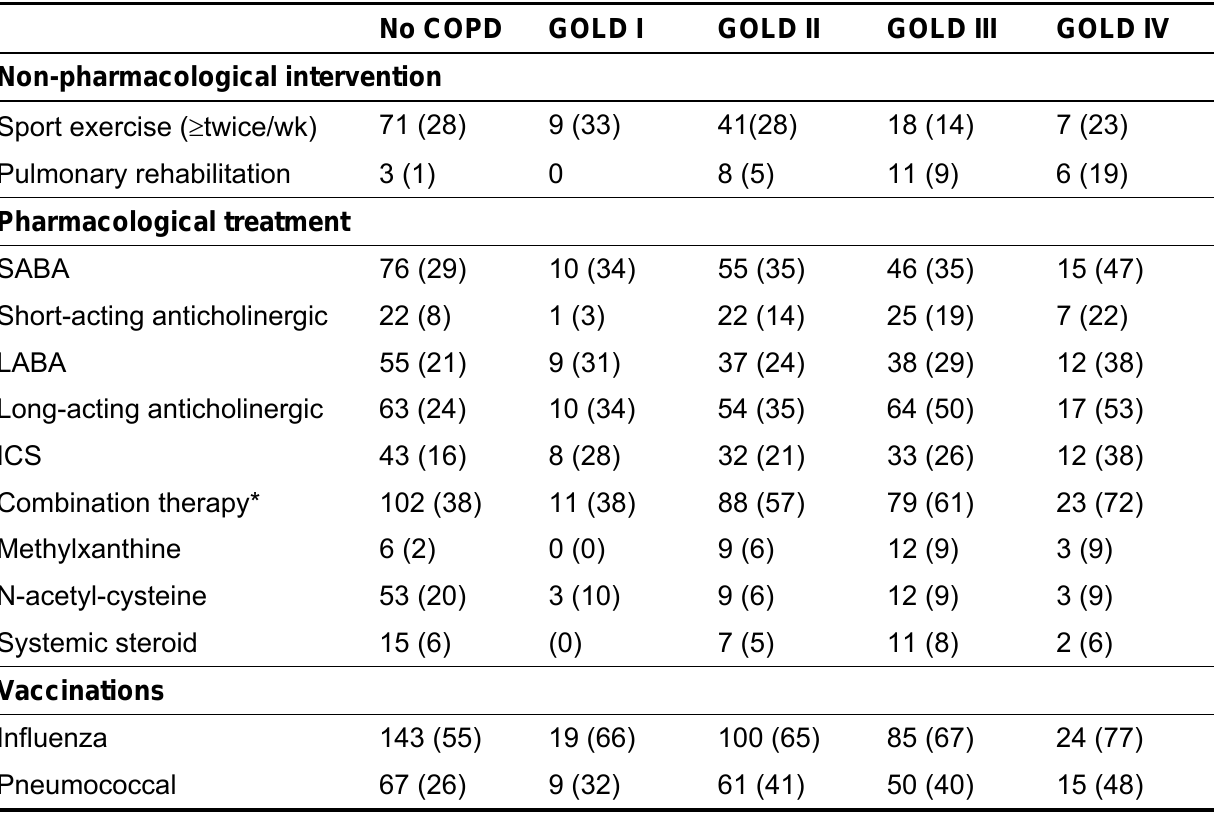
Number of patients receiving